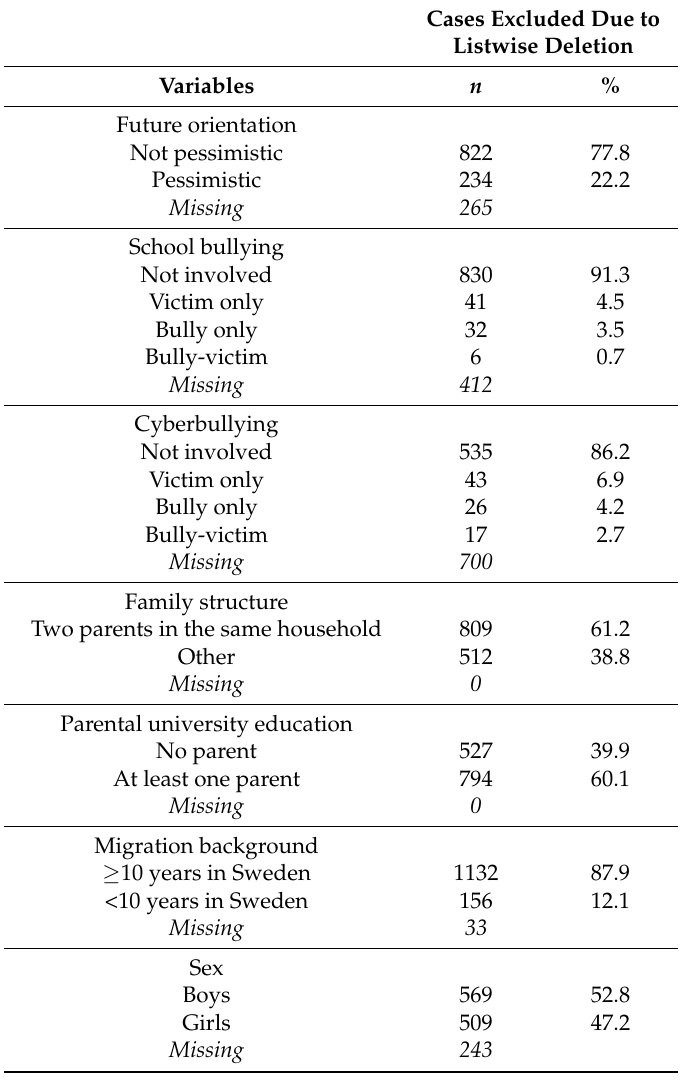
Table A1. Descriptives of the cases excluded due to listwise deletion ( n =